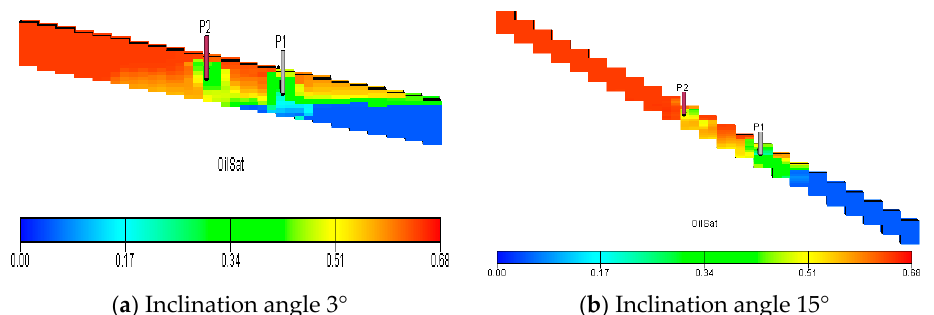
Figure 7. Distribution of oil saturation after validity period.